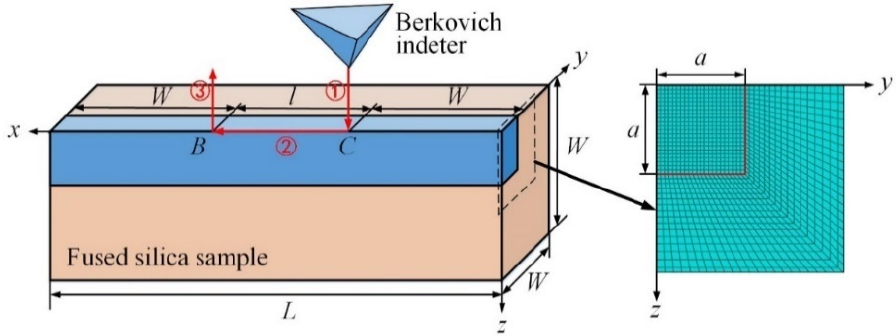
Figure 2. The finite element model of scratching with a Berkovich indenter.